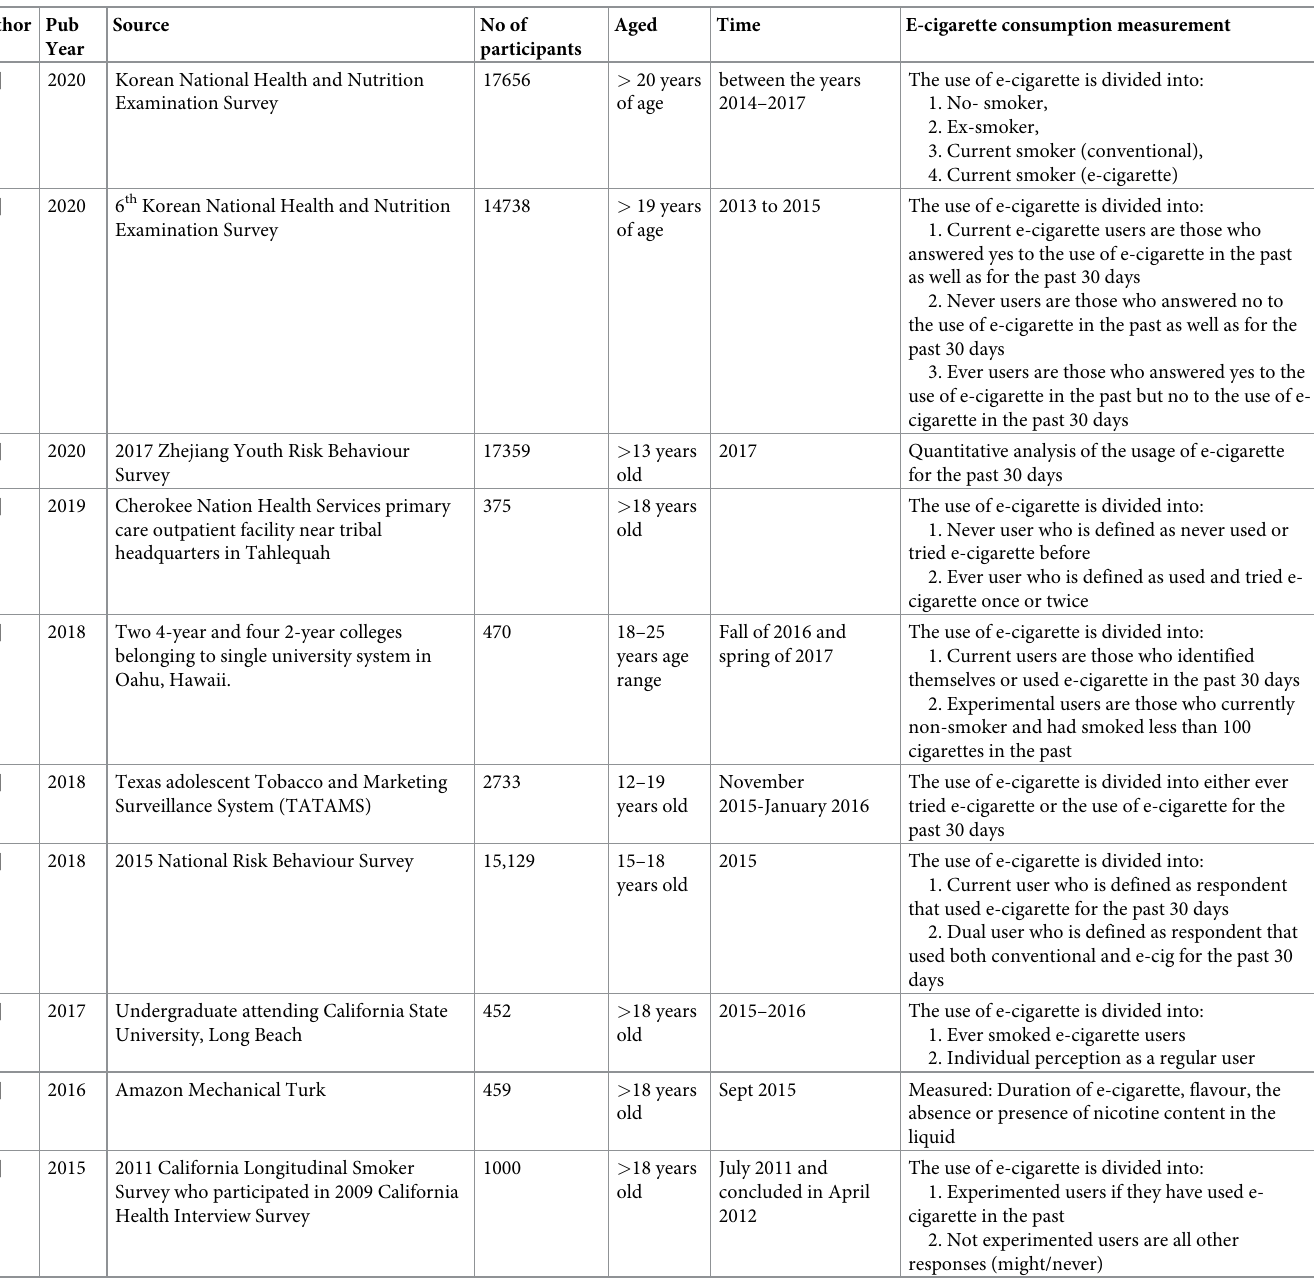
Table 1. Comparison of demographic data and e-cigarette consumption measurement in human